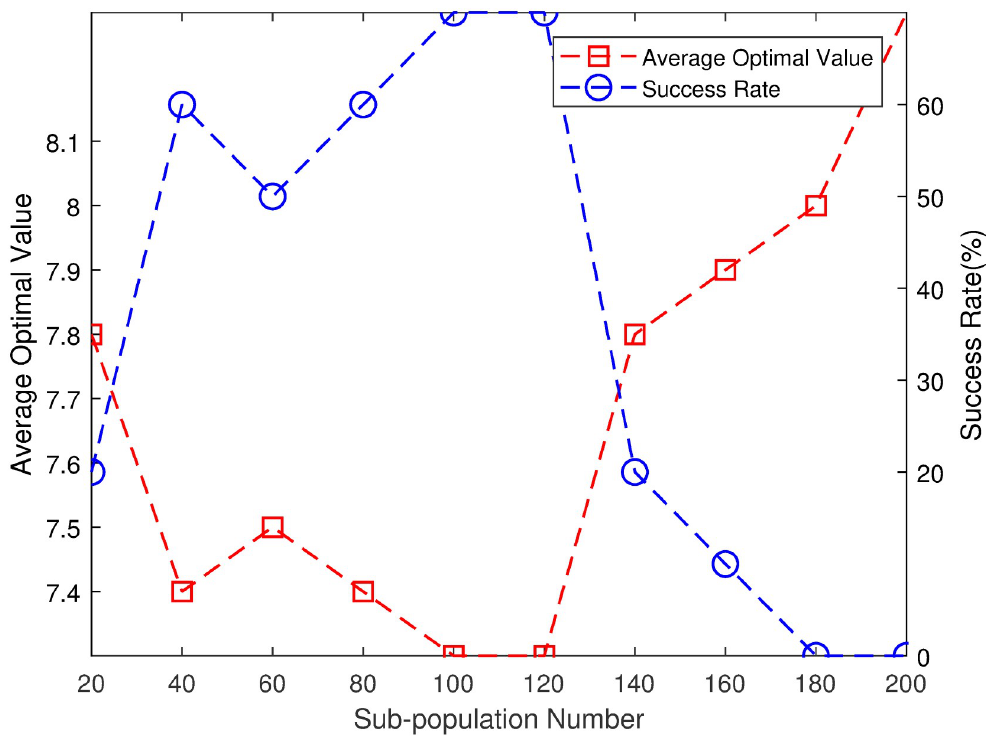
Fig 7. Effect of sub-population number on